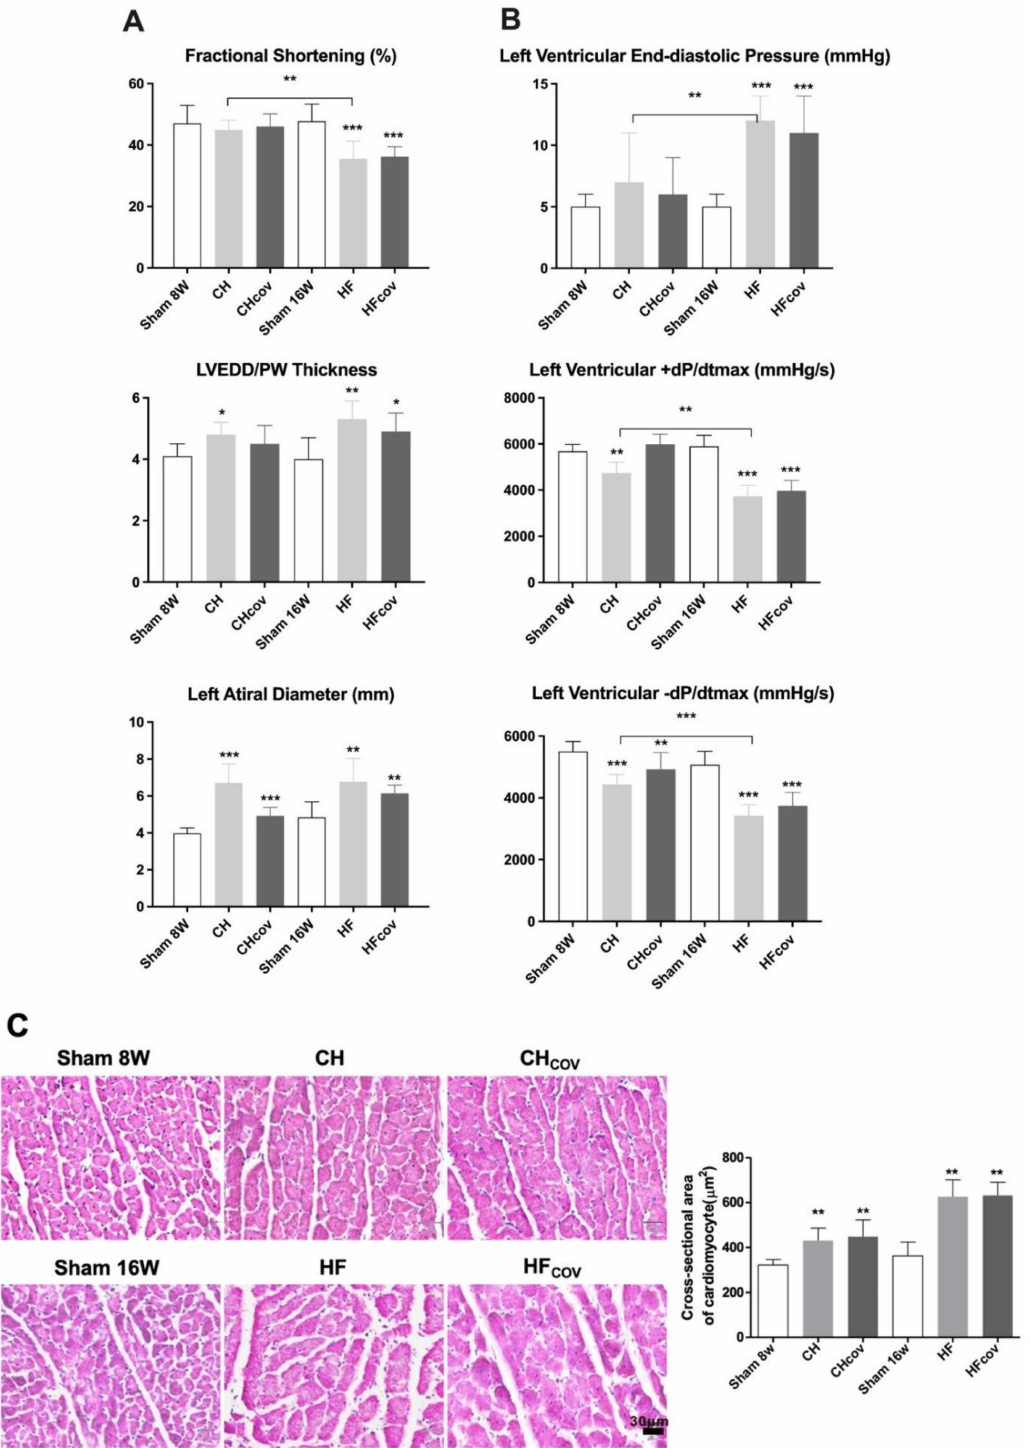
Figure 1. Characterization of rats with volume overload (VO) or with correction of VO. Echocar- diography ( A ) and hemodynamic assessment ( B ) of rats with ACF-induced VO in the compensated hypertrophic (CH) and heart failure (HF) phases, VOed rats with correction of VO in the CH (CH COV ) and HF phases (HF COV ), and the corresponding sham controls. ( C ) Hematoxylin and eosin-stained sections of the left ventricles in different VO phases. The size of cardiomyocytes quantified by the cross-sectional area was compared between VOed rats and corresponding sham controls. n = 6 per group. White, light gray, and dark gray columns represent sham controls, VOed rats, and VOed rats with correction of VO, respectively. *, **, and *** denote p < 0.05, p < 0.01, and p < 0.001, respectively. LVEDD, left ventricular end-diastolic diameter; PW, posterior